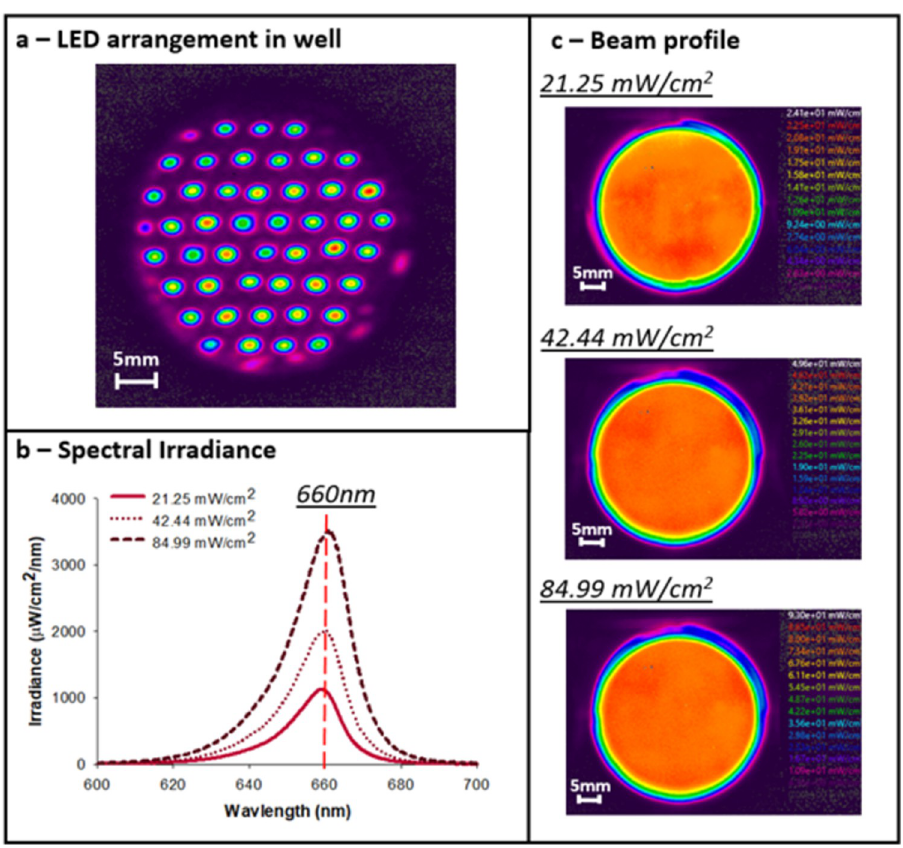
Fig 2. Characterisation of the LED array to confirm spectral irradiance and beam homogeneity. Each well is irradiated by 47 miniature LEDs with Gaussian beam profiles (a). However, at the surface of the 6-well plate a homogenous beam profile is produced due to divergence of the beams from the individual LEDs and scattering at the plate surface. This produces a uniform irradiance with an average irradiance of 21.25 mW/cm 2 , 42.44 mW/cm 2 and 84.99 mW/cm 2 for the three tested light intensities (b and c) (measured at tissue level, with a beam diameter equal to well diameter = 34.8mm). Fluence values for 1 min exposure time: LT1 = 1.28 J/cm 2 ; LT2 = 2.55 J/cm 2 ; LT3 = 5.10 J/ cm 2 . Total power output of array (when delivering 42.44 mW/cm 2 at tissue level) = 4.244